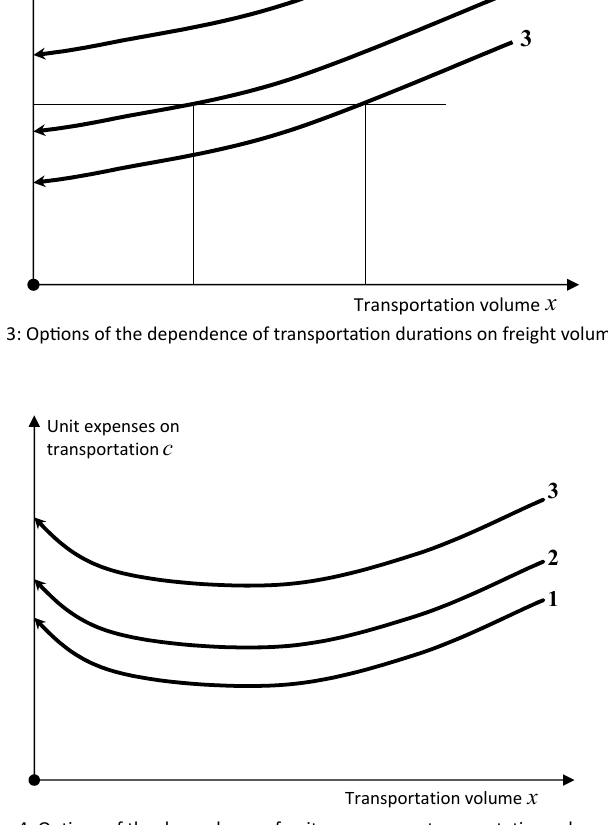
Fig. 4: Options of the dependence of unit expenses on transportation volumes